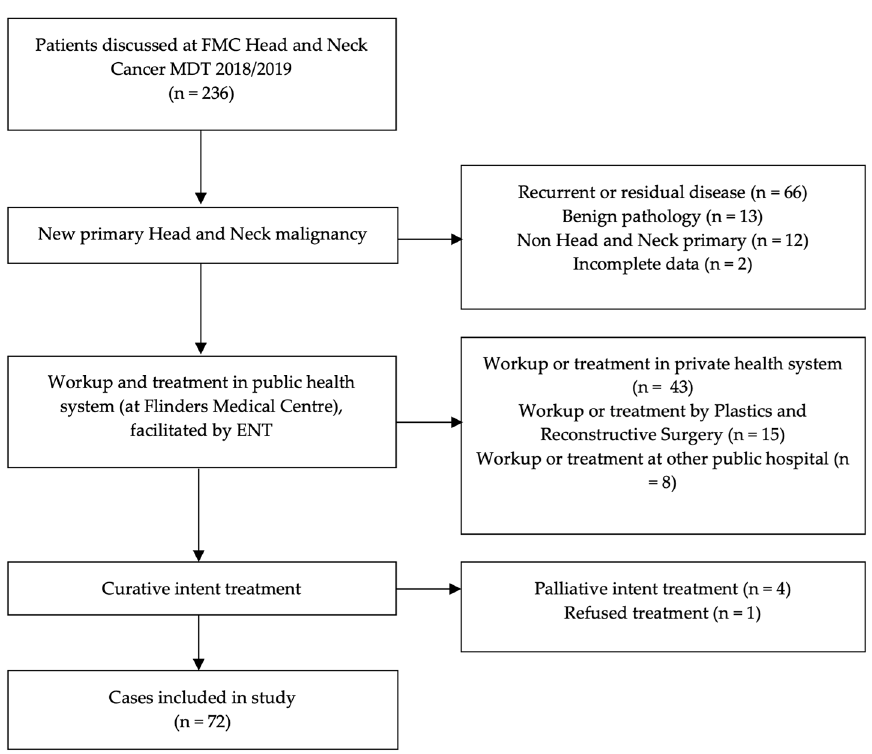
Figure 1. Study data set detailing number and reason for patients excluded from analysis.